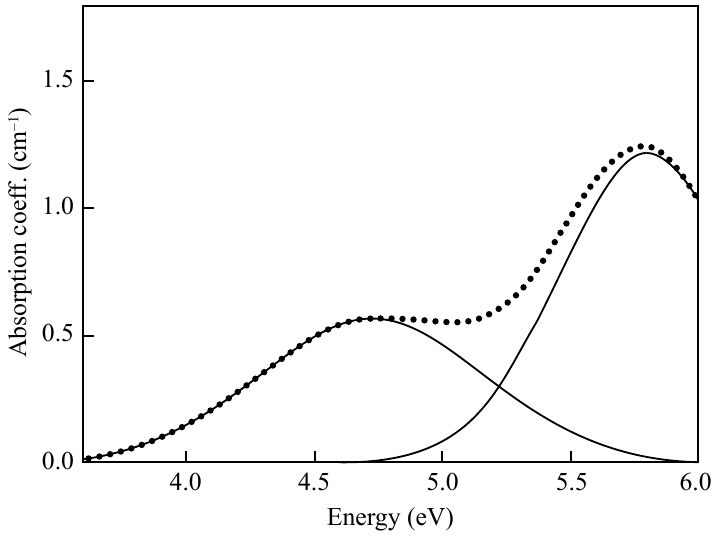
Figure 5. Optical absorption spectrum of a synthetic silica sample showing a band assigned to the E (cid:48) center (5.8eV) and another band assigned to NBOHC (4.8eV). Adapted from Cannas et al.